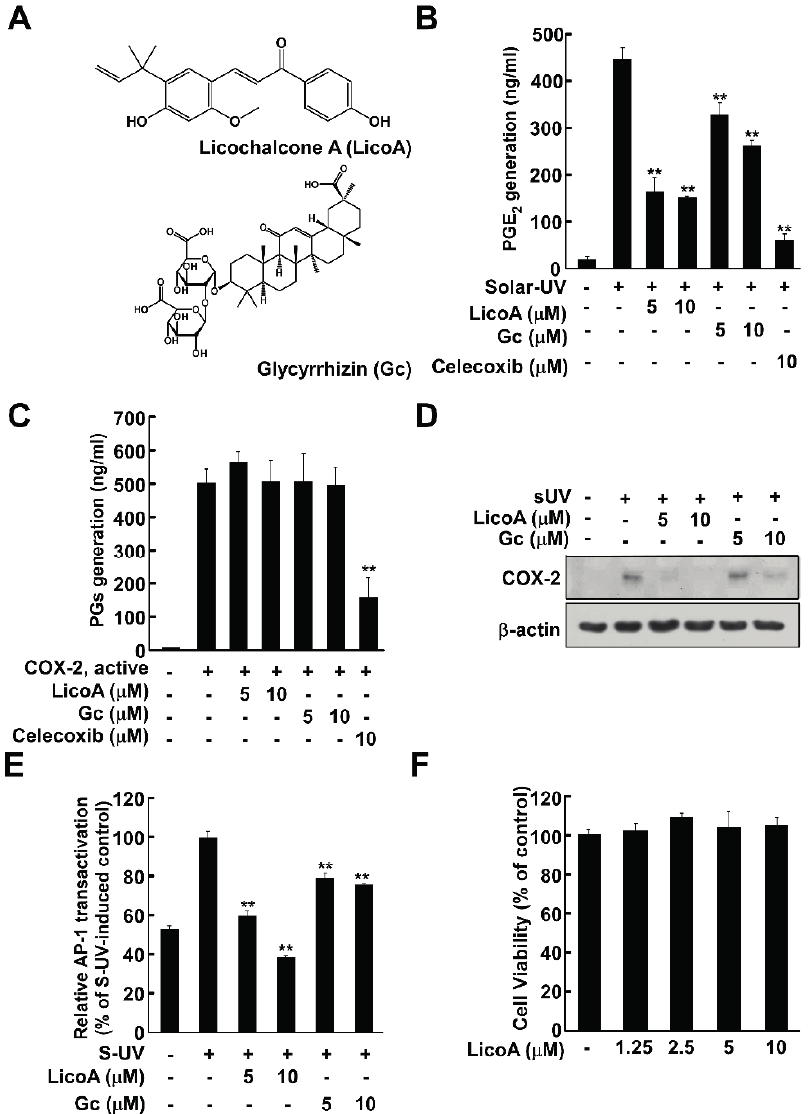
Figure 1. Treatment with licochalcone A (LicoA) but not Glycyrrhizin (Gc) inhibits solar ultraviolet (sUV)-induced prostaglandin E2 PGE 2 production by